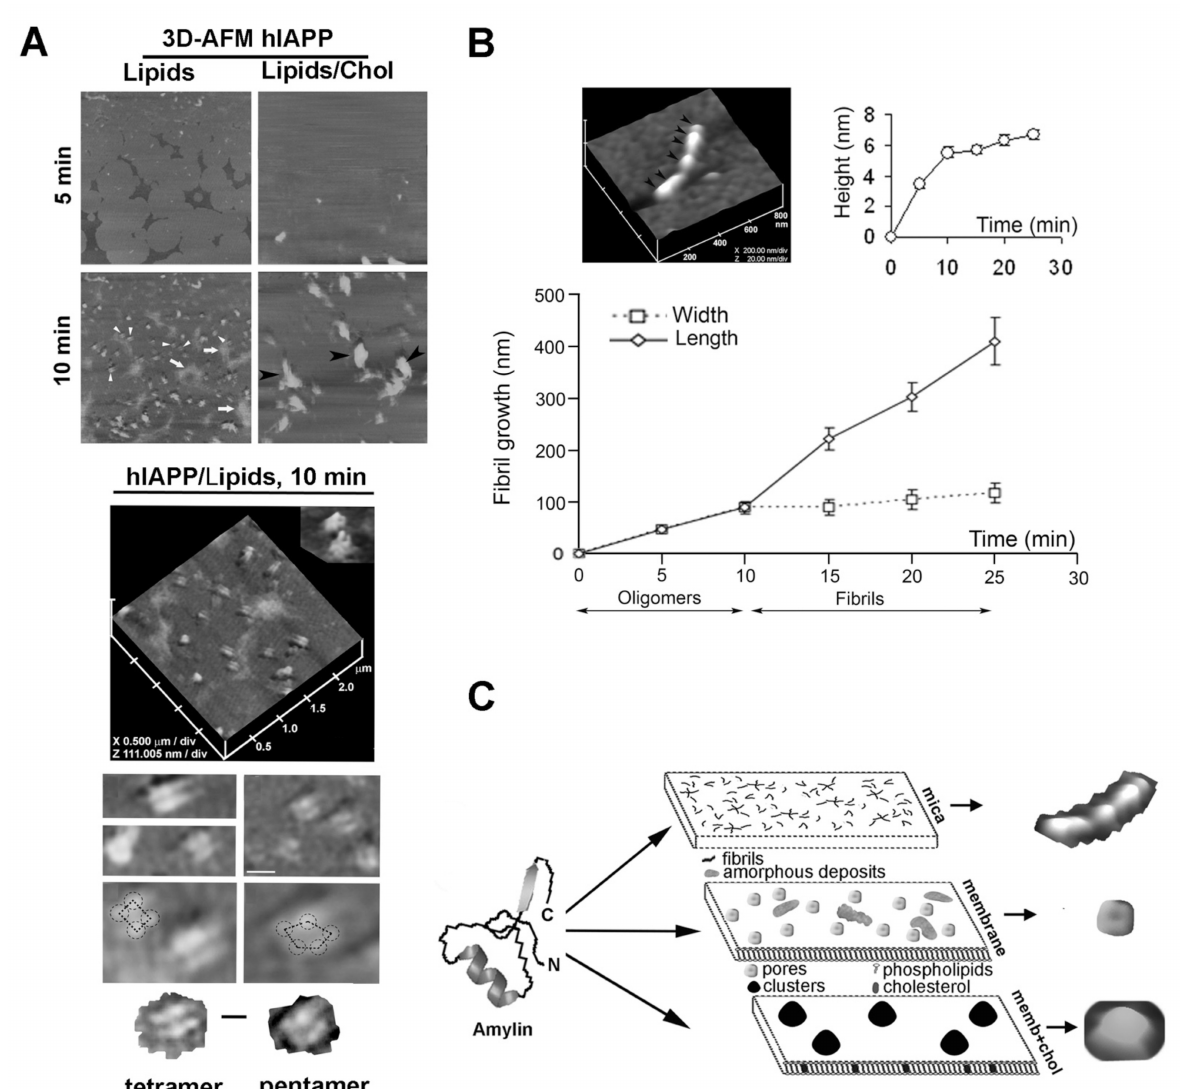
Figure 4. Polymerization pathways and polymorphic structures of hIAPP on different